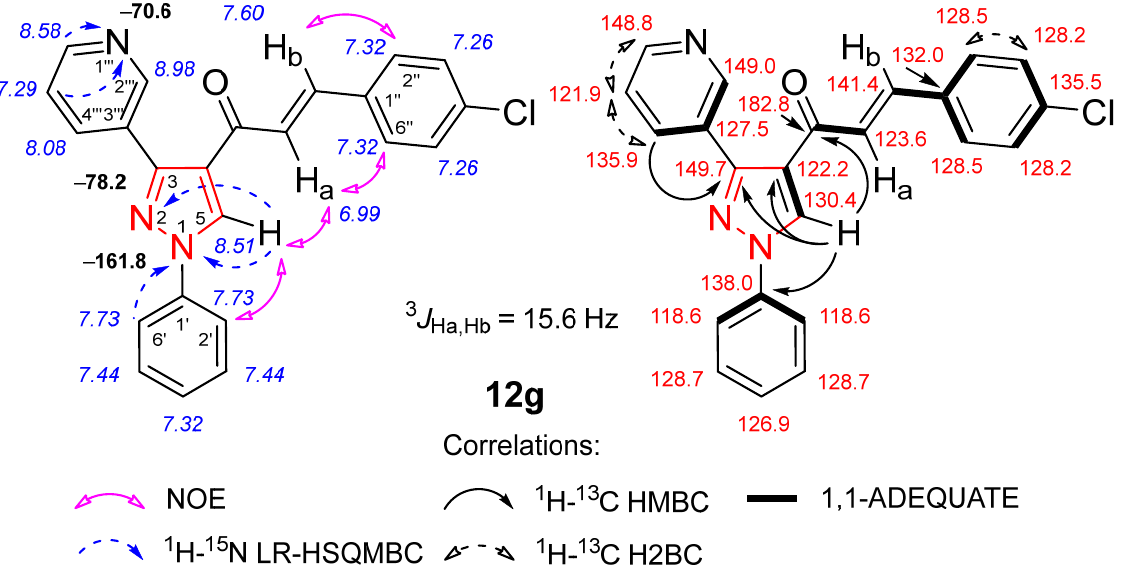
Figure 4. Relevant 1 H- 13 C HMBC, 1 H- 13 C H2BC, 1 H- 15 N LR-HSQMBC, 1 H- 1 H NOESY and 1,1-ADEQUATE correlations and 1 H NMR (italics), 13 C NMR and 15 N NMR (bold) chemical shifts of compound 12g .